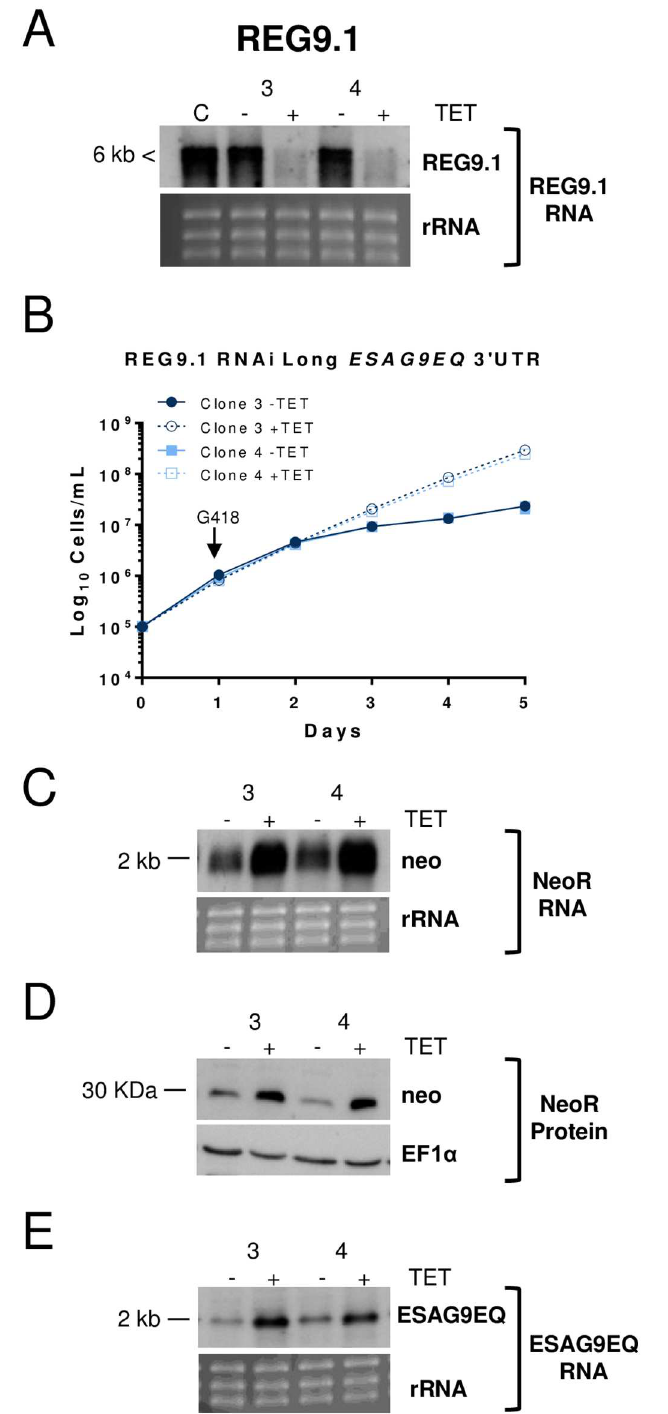
Fig 2. Validation of RNAi lines silencing REG9.1 selected from the RNAi library. A. Northernblot demonstrating the induciblegene silencingof REG9 . 1 .Two independent RNAi clones were analysed ( REG9 . 1 , clone 3 and 4).); rRNA was used as a loadingcontrol. Smearing is caused by the transcript being larger than 6 kb. B. G418 resistance(at 10 μ g/ml)of the respectiveRNAi clones when RNAi was inducedor not. RNAi resulted in decreased sensitivity to G418. Error bars (obscured by the symbols) symbolizestandard deviations of the triplicate assays of each clone ± tetracycline. C. Northernblot of NeoR transcript levels when